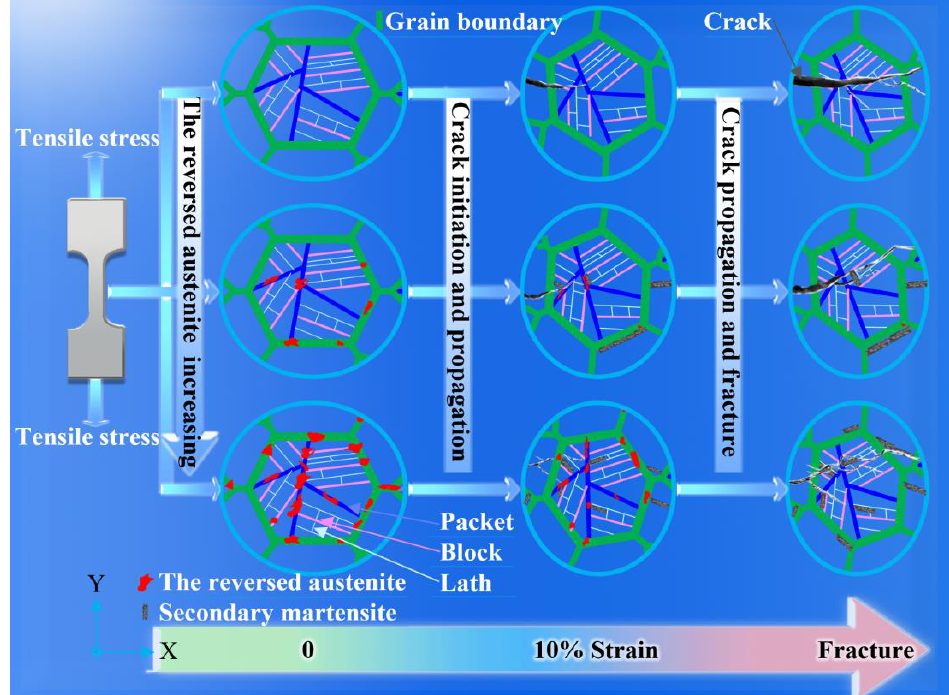
Figure 8. The schematic diagram of the mechanisms governing the effect of reversed austenite on strength and elongation.